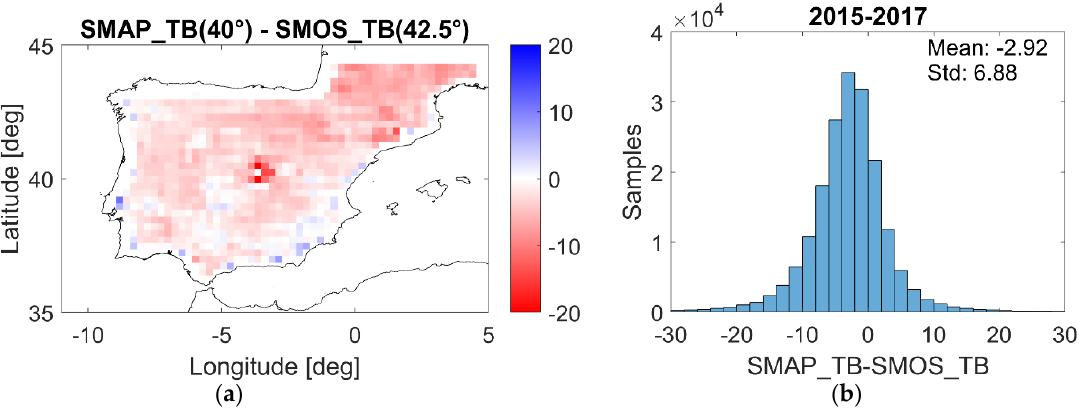
Figure 7. ( a ) Temporally averaged map of daily T B di ff erences between SMAP (40 ◦ incidence angle) and SMOS (42.5 ◦ incidence angle) at 25 km and ( b ) histogram of temporally-averaged daily T B di ff erences, for the period April 2015 to December